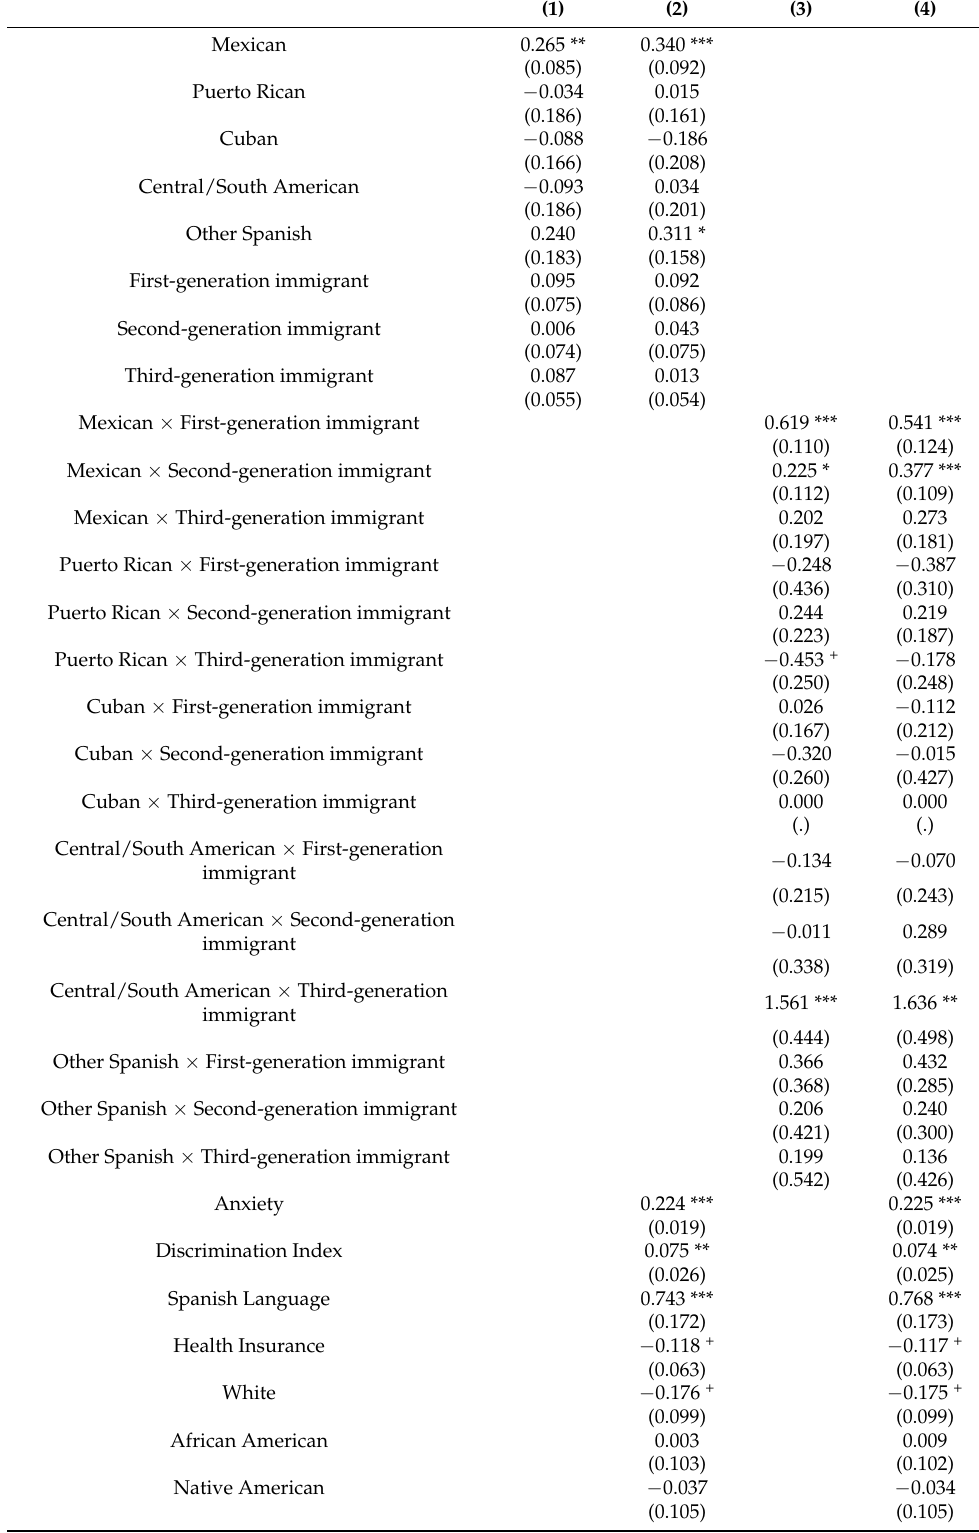
Table 5. Perceived Risk of Dying, by